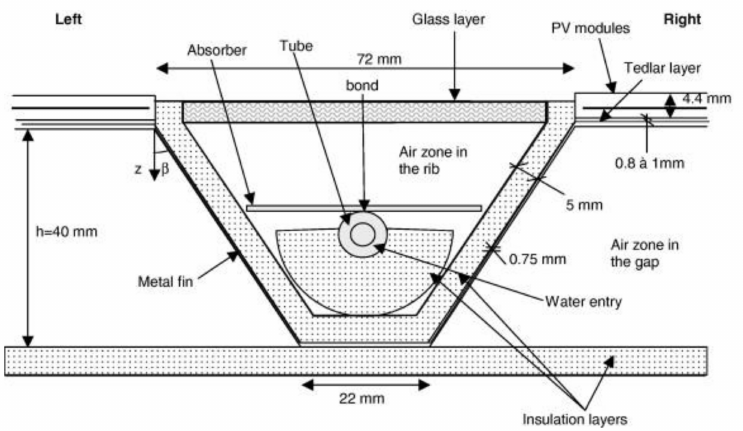
Figure 30. Cross-section of PVT bi-fluid system (reprinted from [141], with permission from